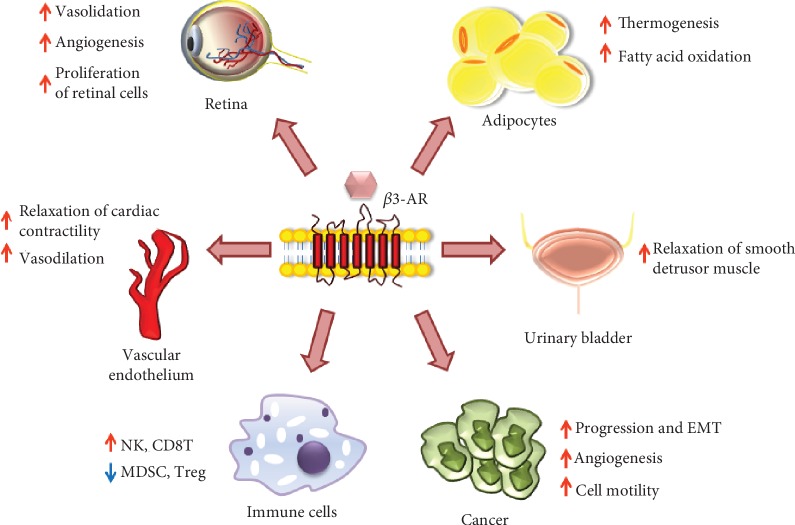

β3-AR role in different cells and tissues.